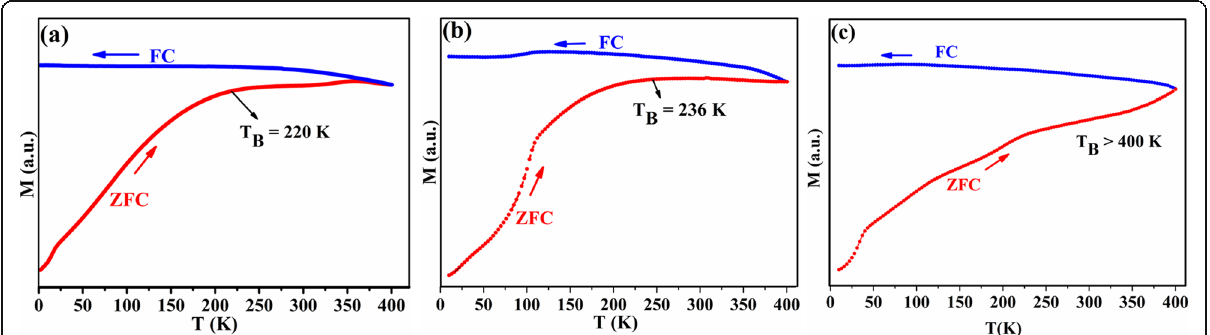
Fig. 8 ZFC-FC ( M - T ) curves at low temperatures ( H = 200 Oe) for the pristine Fe 3 O 4 a before heating b Pristine Fe 3 O 4 with cement used as glue after heating up to 600 K and c 900